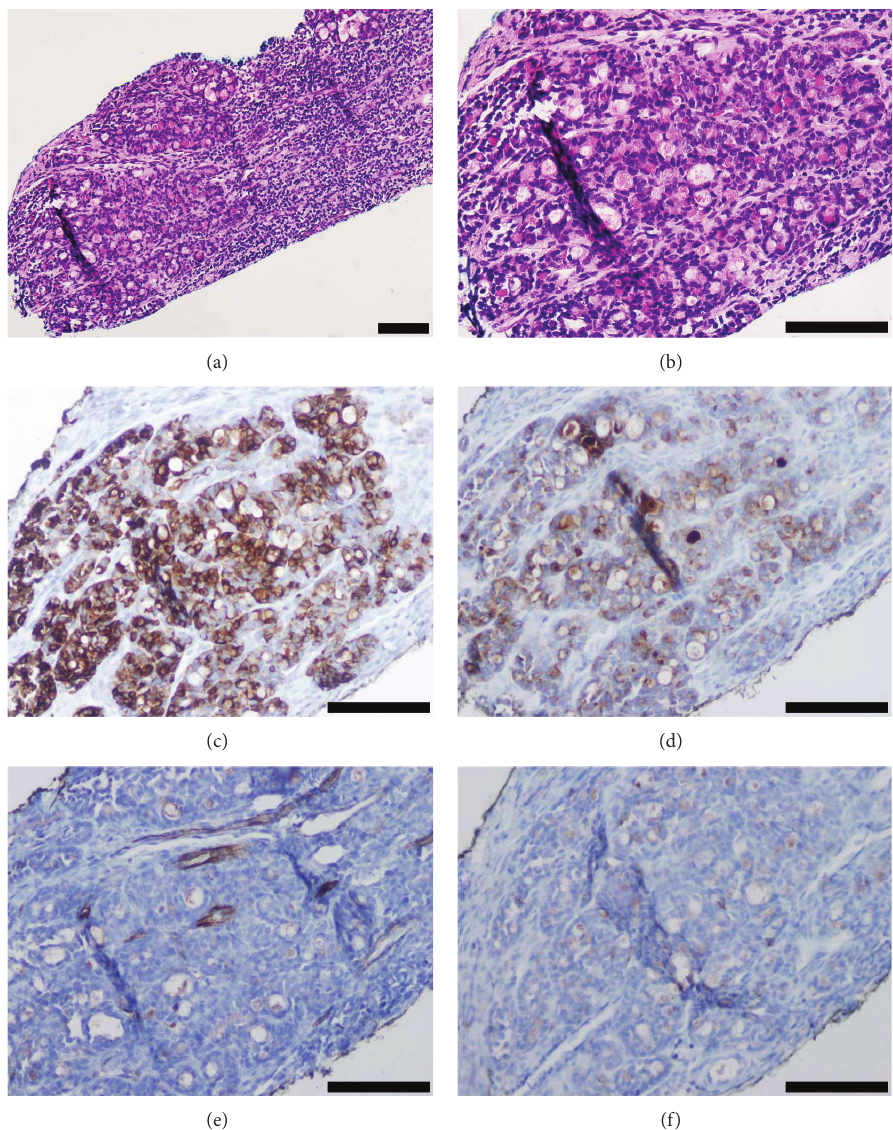
Figure 2: Histologic and immunophenotypic features of TLFCK on biopsy. (a) Low power view of biopsy showed an atypical area with microfollicles surrounded by chronic inflammatory reaction. (b) High power view demonstrated microfollicles with eosinophilic material filling tubular lumens. ((c) and (d)) Immunohistochemical staining of tumor cells showed reactivity for (c) CK7 and (d) EMA. ((e) and (f)) Tumor cells lacked immunoreactivity for (e) WT-1 and (f) CD56. Scale bars represent 100 𝜇